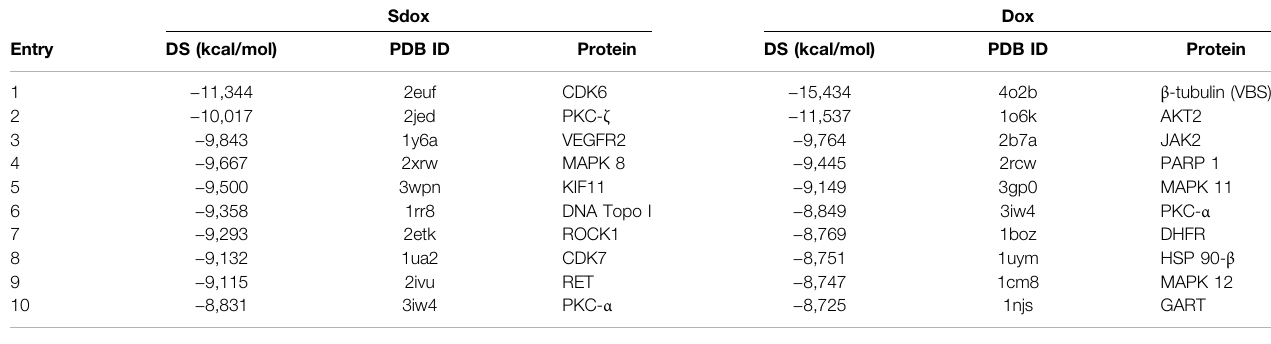
TABLE 5 | Top-ranked drug-protein interactions obtained for Sdox and Dox.